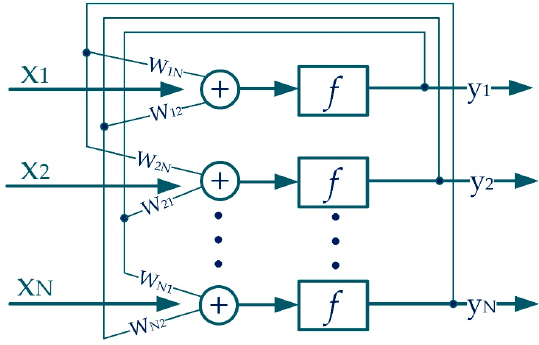
Figure 5. Structure of the Recurrent Hopfield Network—RHN.